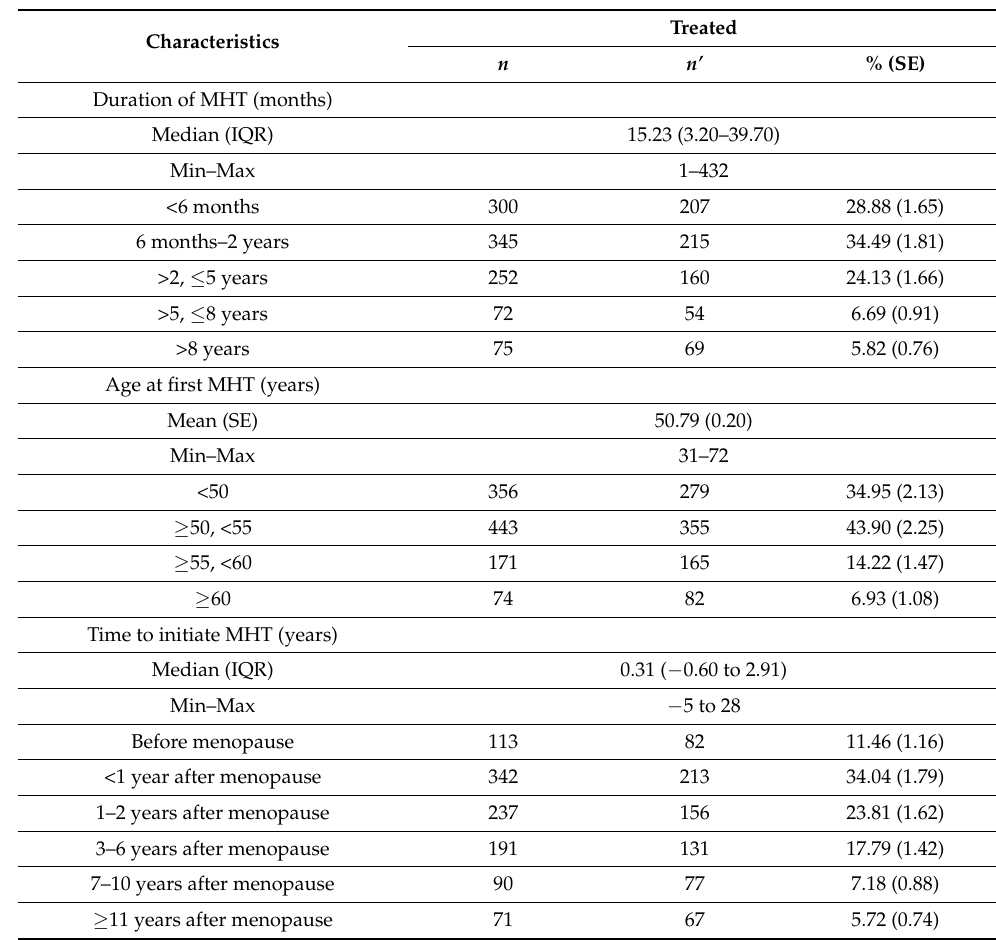
Table 3. MHT-related information in treatment